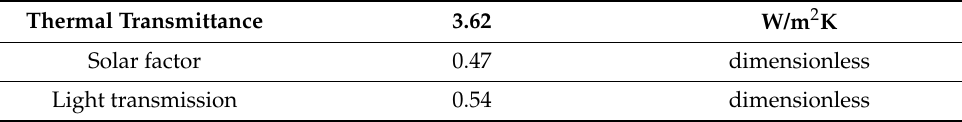
Table 5. Characteristics of openings of the Girona Cathedral